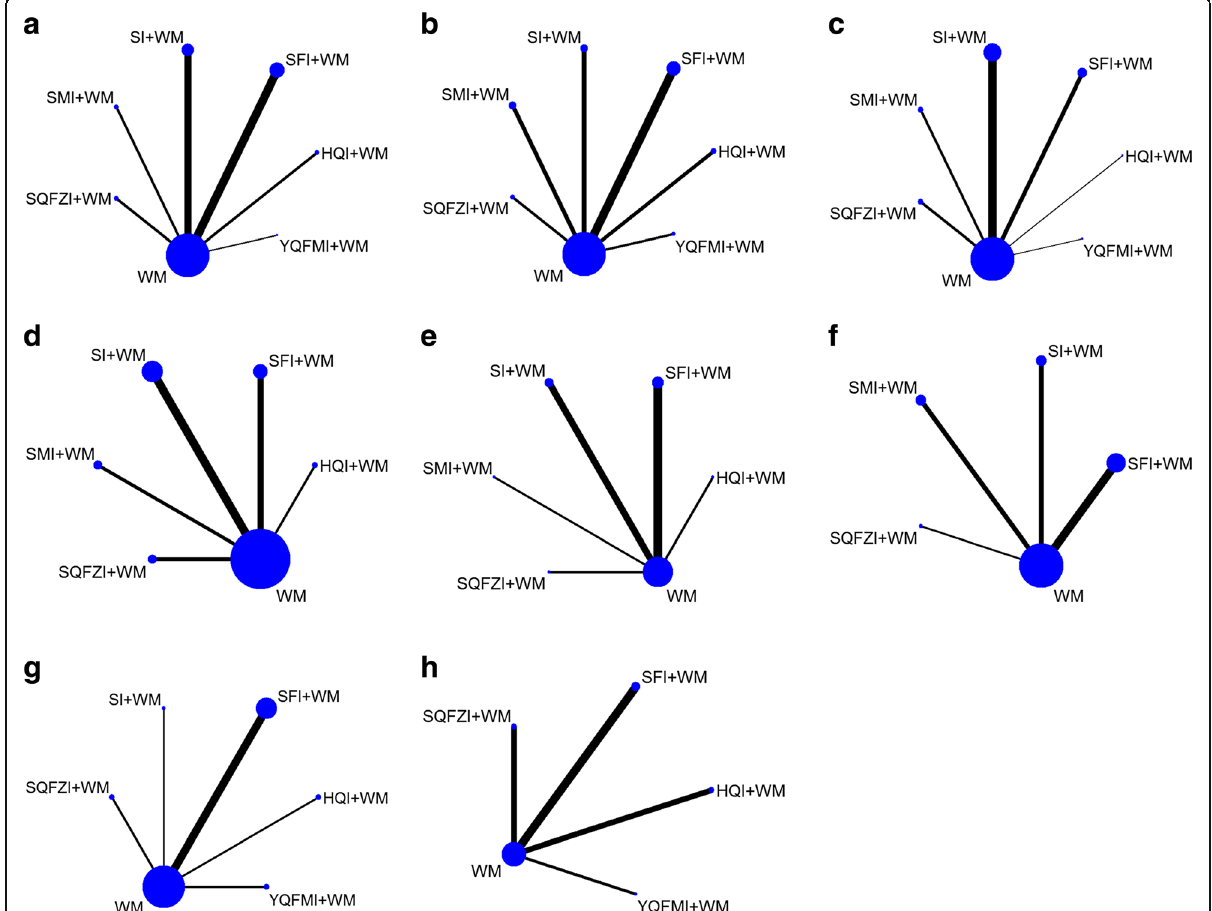
Fig. 2 Network graph of the clinical effective rate, LVEF, CO, SV, 6MWT, BNP, LVEDD and LVESD. Note: a : the clinical effective rate; b : LVEF; c : CO; d : SV; e : 6MWT; f : BNP; g : LVEDD; h :